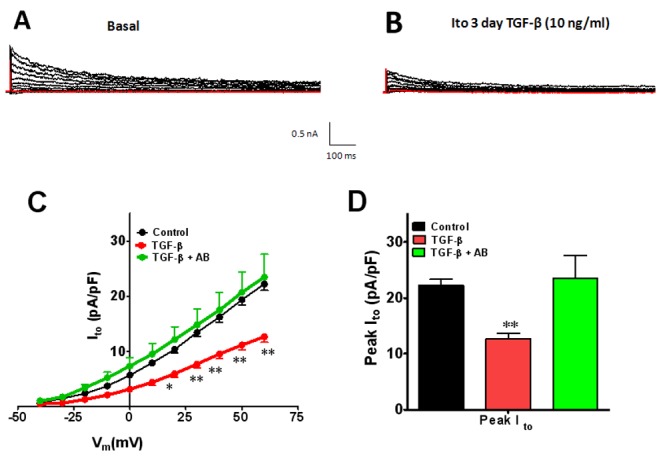
Effects of TGF-β1 on outward potassium current (Ito) after 72 hr treatment.Representative current traces A) control, B) TGF-β1, Ito IV relation at voltages between −40 and +60 mV for control (black), TGF-β1 (red) and TGF-β1+TGF-β1 antibody (AB) is shown in panel C. D) peak Ito under control conditions. Values are mean ± standard error. N = 8−18 cells from 5 different isolations. *indicates p<0.05, **indicates p<0.01, ***indicates p<0.001 significant difference between control and TGF-β1 treated cells.